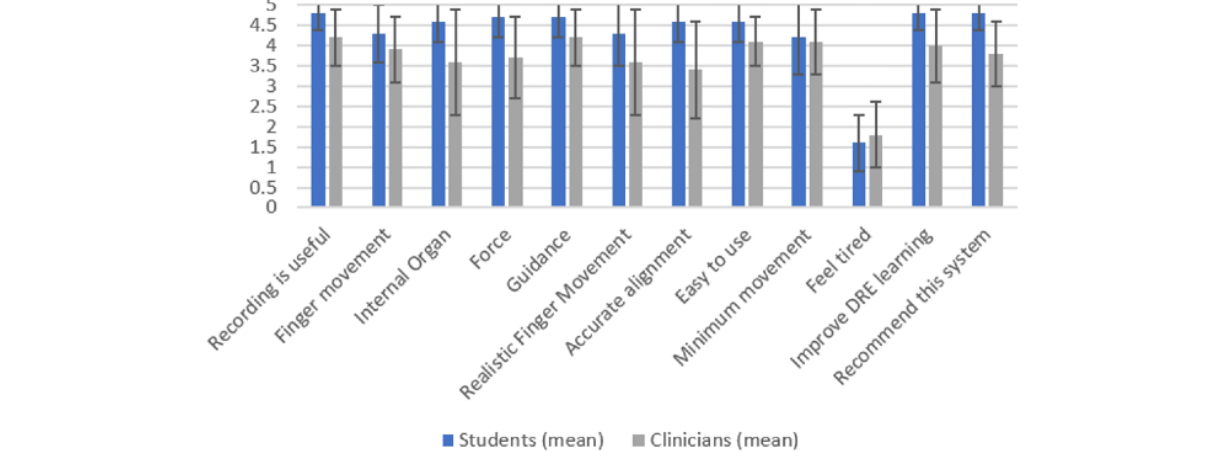
Figure 15. Comparison between questionnaire results from medical students and clinicians (1 = definitely disagree, 5 = definitely agree) regarding the usefulness of the augmented reality system. DRE: digital rectal